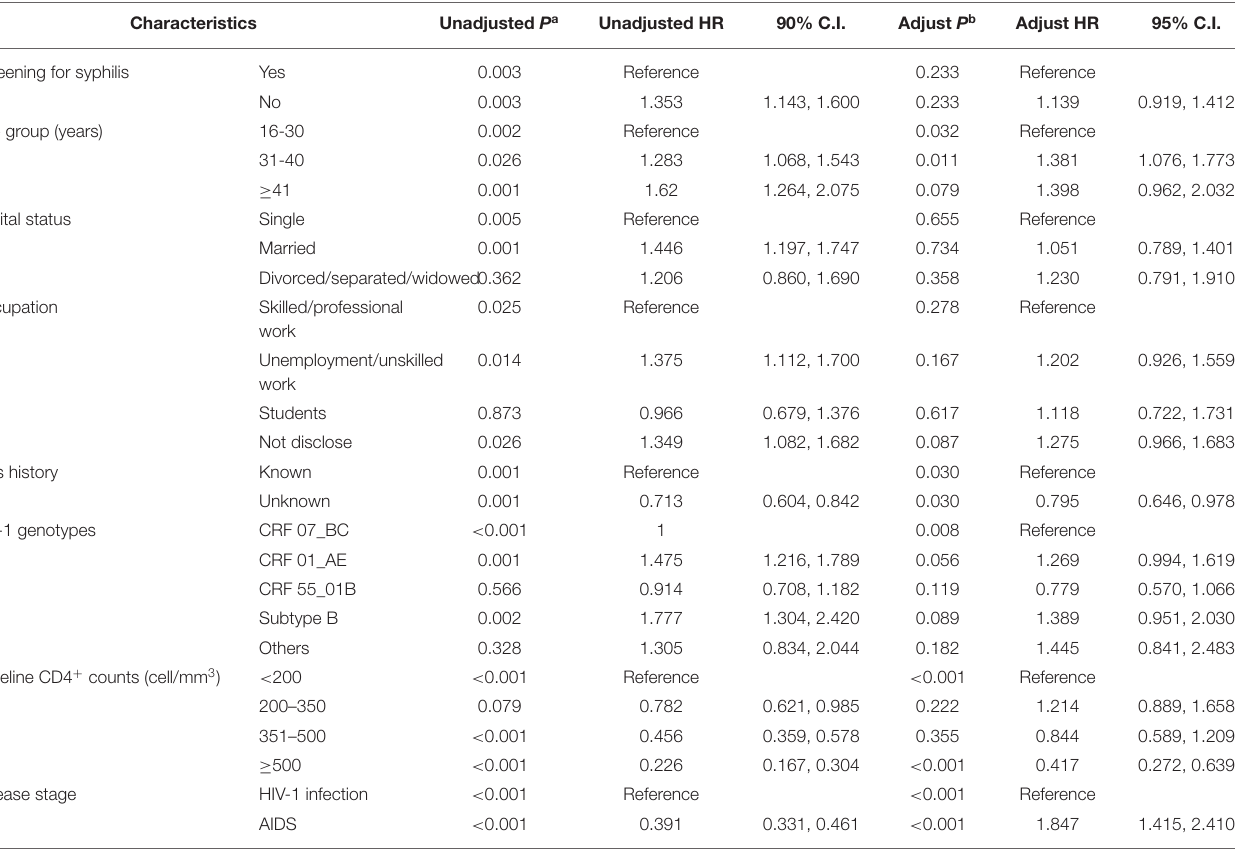
TABLE 5 | Factors associated with the time from HIV-1 diagnosis to antiretroviral treatment initiation between HIV-infected MSM with or without syphilis screening during 2008 and 2012 in Guangzhou, China. Characteristics Unadjusted P a Unadjusted HR 90%